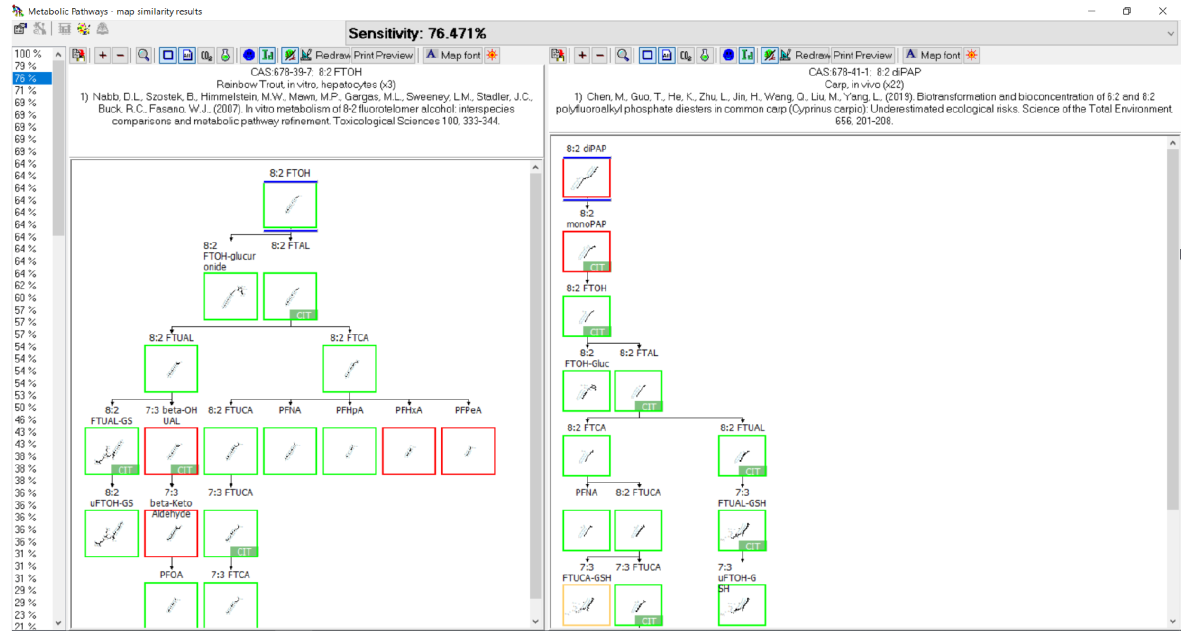
Figure 18. Metabolic map comparison of 8:2 FTOH in ( left ) rainbow trout hepatocytes and ( right ) in vivo pig. Metabolites common to both species are indicated by green boxes. Differences in metabolites are indicated by red boxes. Tan boxes indicate phase II conjugates. Sensitivity, in this case 69.231%, is an assessment of the map comparison whereby the number of common metabolites is divided by the total number of metabolites in the fish map. Metabolites labeled with CIT are presumed intermediates in the path but were not identified in the study.